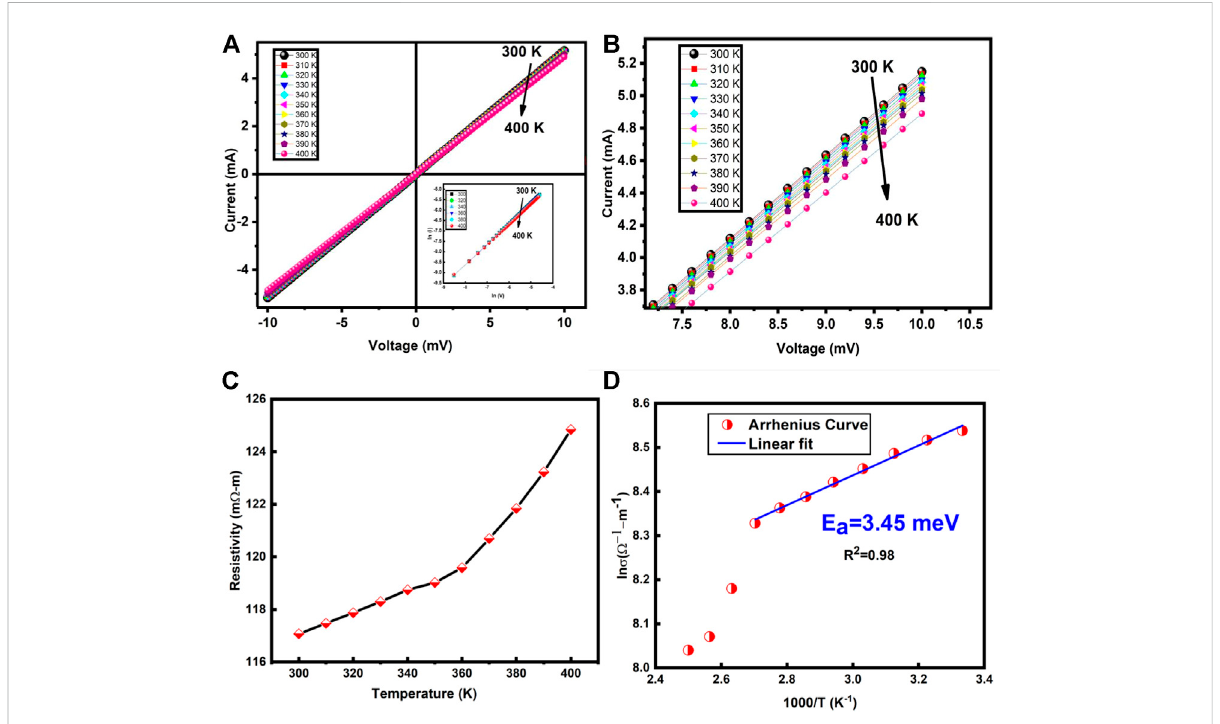
FIGURE 6 (A) IV response of NiCo 2 S 4 at different temperaturesand (inset) is thedouble logarithm graph of NiCo 2 S 4 showing ohmic behavior. (B) Zoomed IV characteristics curves of NiCo 2 S 4 (C) Resistivity varition with temperature (D) Arrhenius plot for the calculation of the activation energy.